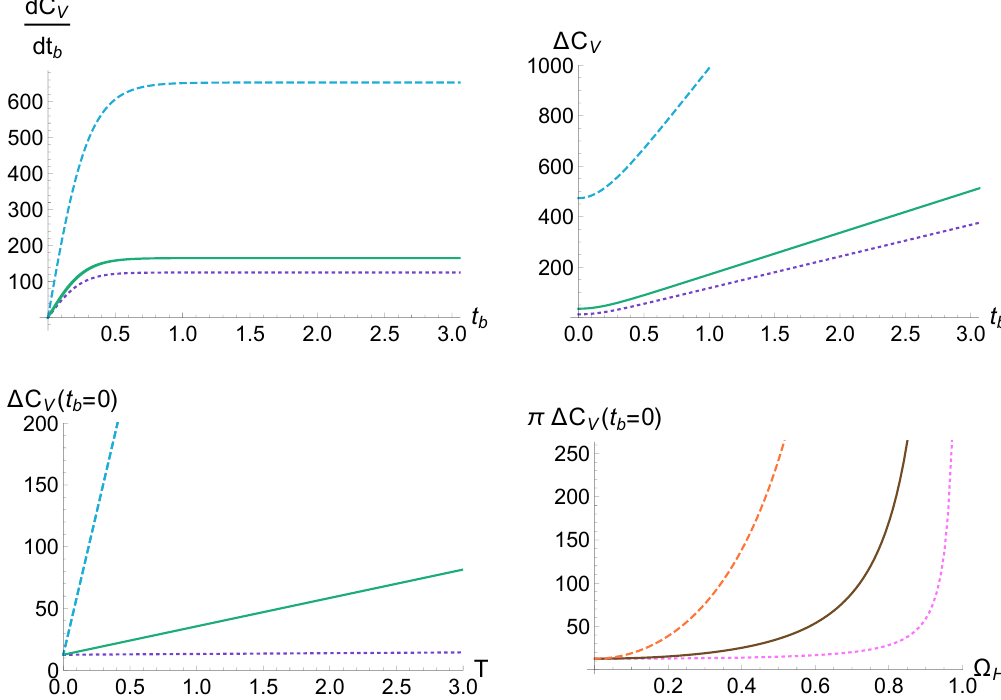
Figure 10 . Above: time dependence of (left) dC V Ω H = 0 . 1 (dotted purple), Ω H = 0 . 5 (solid green), Ω H = 0 . 9 (dashed blue). Below: ∆ C V ( t b = 0) for ‘ = G N = 1 and (left) Ω H = 0 . 1 (dotted purple), Ω H = 0 . 5 (solid green), Ω H = 0 . 9 (dashed blue), (right) T = 0 . 1 (dotted pink), T = 1 (solid brown), T = 10 (dashed